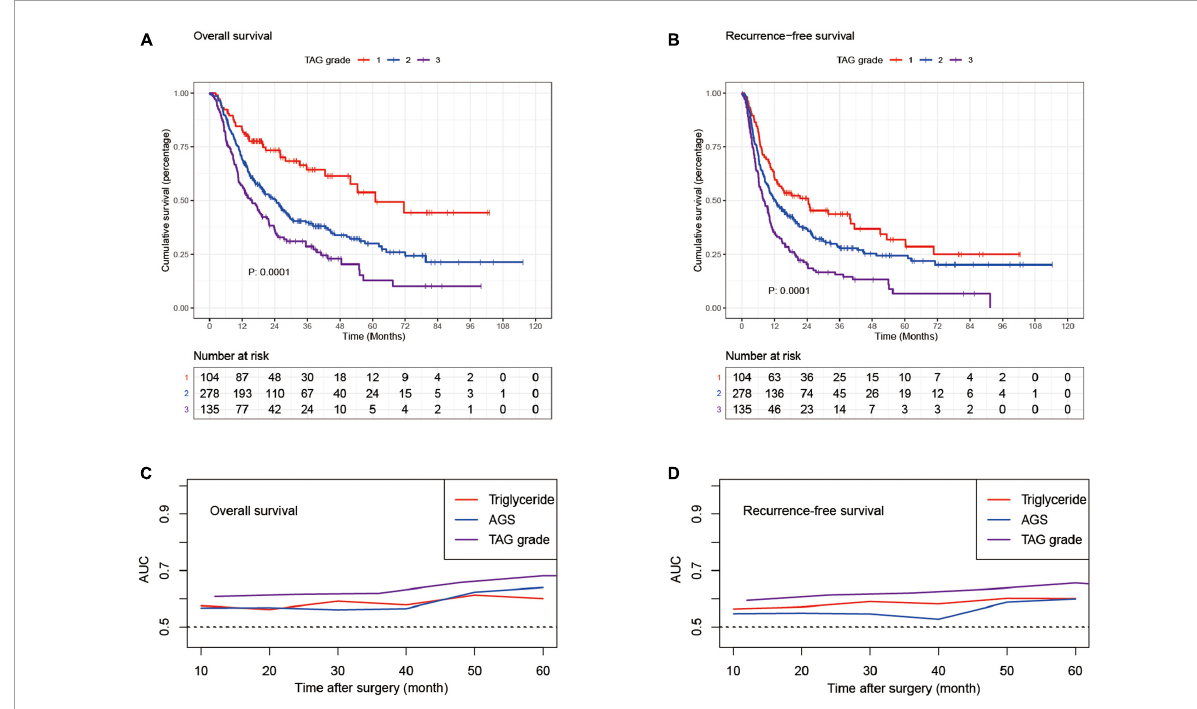
FIGURE3 Kaplan–Meier curves for overall survival and recurrence-free survival stratified by TAG grade (A,B) in the discovery set; time-dependent AUROC curves of triglyceride, AGS and TAG grade for overall survival (C) and recurrence-free survival (D) in the discovery set; AUROC, area under receiver operating characteristic; AGS, albumin-globulin score; TAG grade, triglyceride-albumin-globulin